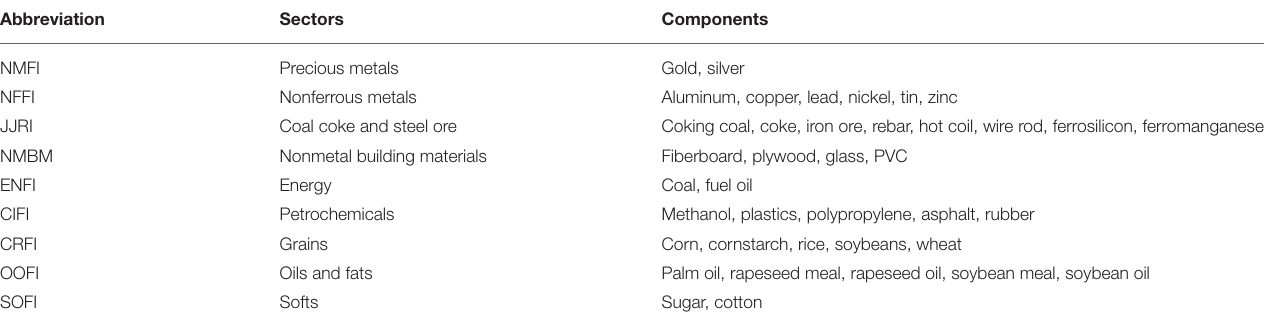
TABLE 1 | China’s commodity sectors and the detailed components.